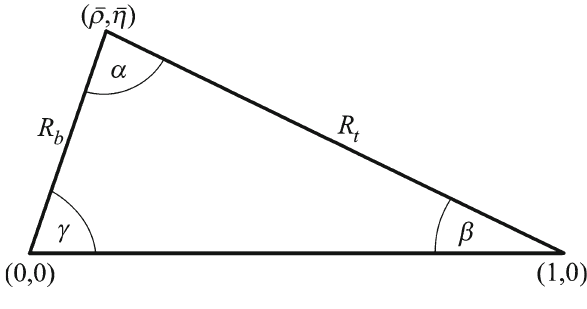
Fig. 1 The unitarity